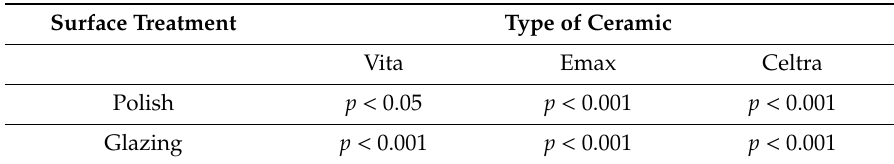
Table 5. One-way ANOVA statistical analysis based on surface treatments polished and glazed before and after thermocycling for Ra parameter.